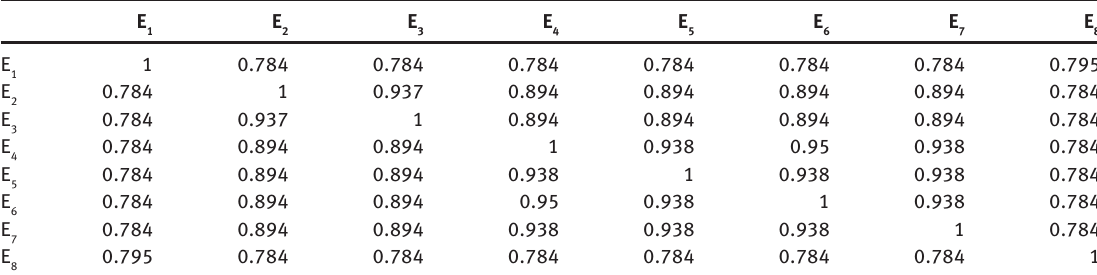
Table 3: Classification of Experts: Fuzzy Equivalence Relation Obtained Using the Max-Min Method (Eight Experts, 226